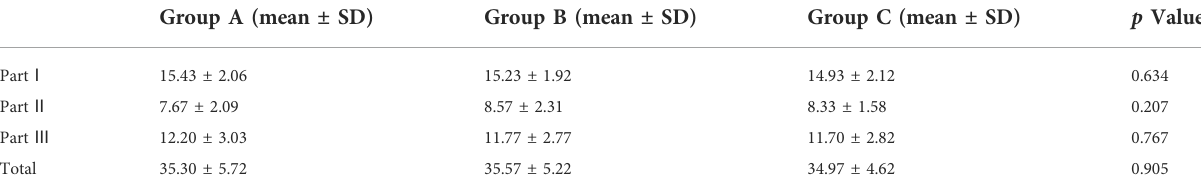
TABLE 3 Pre-lecture scores of three groups.